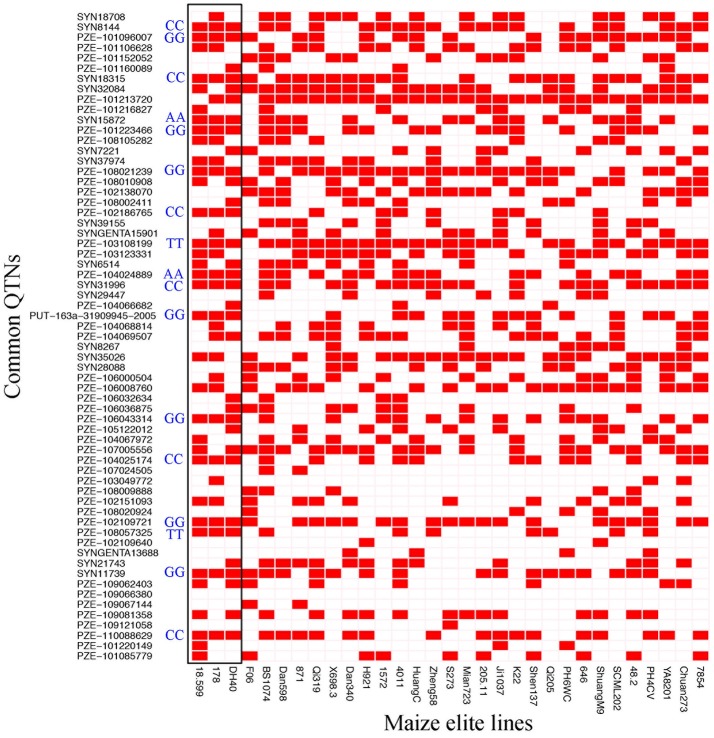
Heat map of the superior alleles distribution for the 63 QTNs in 31 elite inbred lines. Red and White colors represent superior and inferior alleles, respectively. Black box means the superior alleles distribution for the 63 QTNs in high-regeneration lines 18-599, 178, and DH40. AA, TT, GG, and CC represent the genotypes for common superior alleles in 18-599, 178, and DH40.